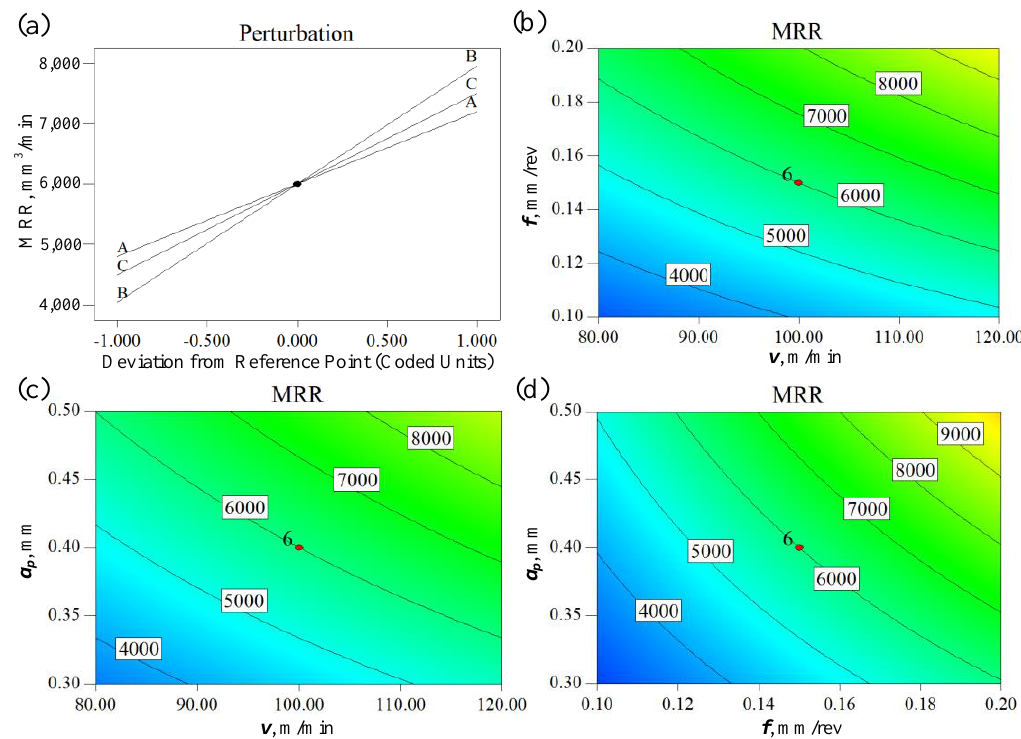
Figure 10. E ff ect of cutting parameters on MRR. ( a ) Perturbation plot of the e ff ect of cutting parameters Figure 10. Effect of cutting parameters on MRR. ( a ) Perturbation plot of the effect of cutting on MRR, ( b ) contour plot of the e ff ect of cutting speed and feed on MRR, ( c ) contour plot of the e ff ect of parameters on MRR, ( b ) contour plot of the effect of cutting speed and feed on MRR, ( c ) contour plot cutting speed and depth of cut on MRR, ( d ) contour plot of the e ff ect of feed and depth of cut on MRR. of the effect of cutting speed and depth of cut on MRR, ( d ) contour plot of the effect of feed and depth of cut on MRR. SCE was related to cutting power and MRR. Cutting power was the energy consumed per